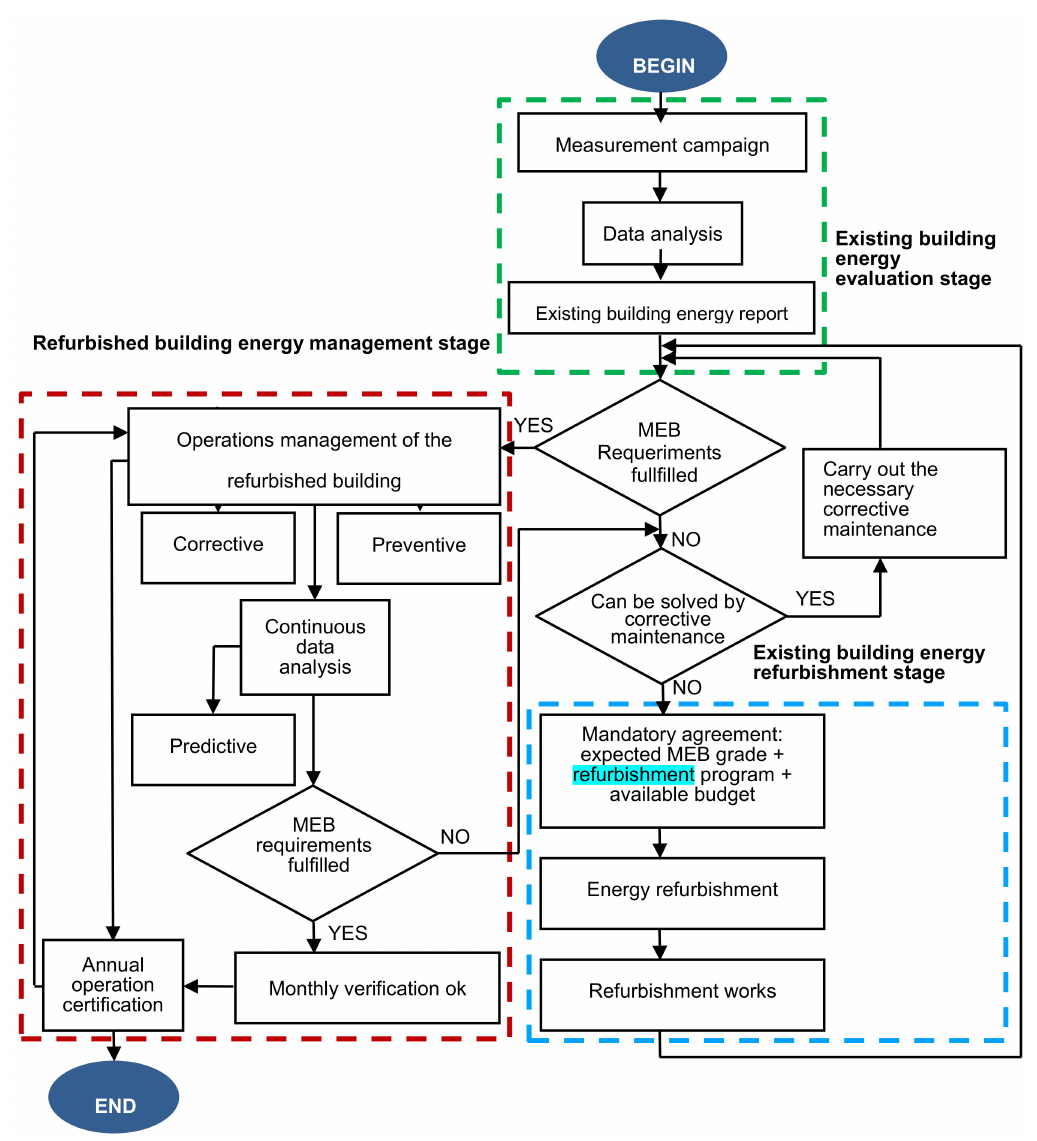
Figure 1. uhuMEBr